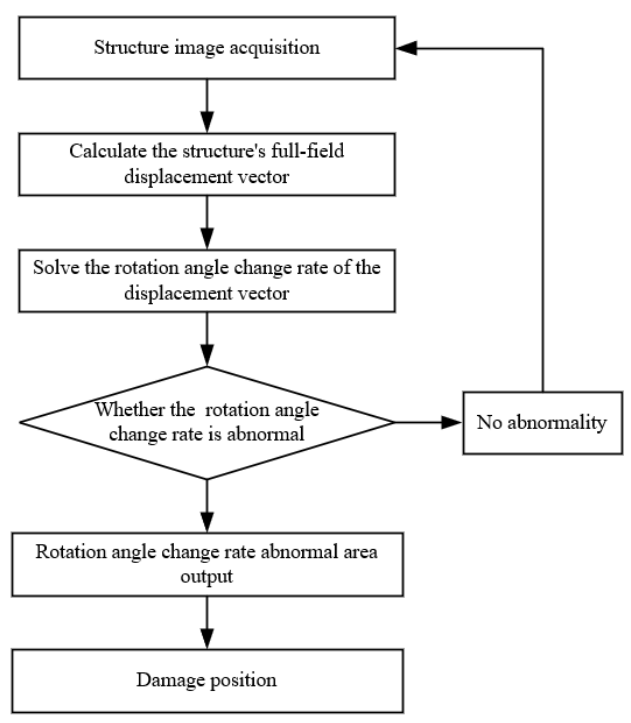
Figure 36. Damage identification